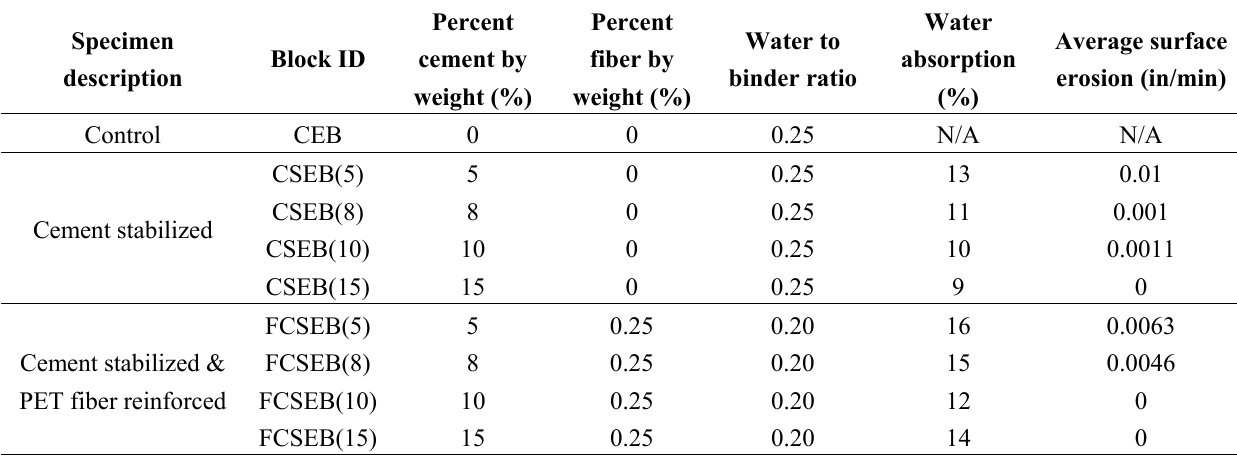
Table 4. Test matrix and average